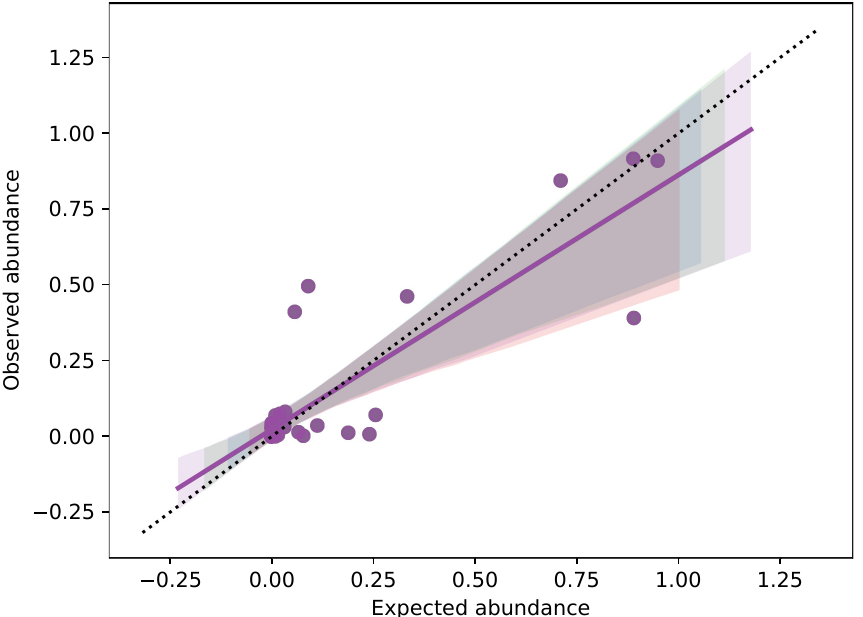
Figure 4. Plots of accuracy and observation correlations for each samples in the five fruit